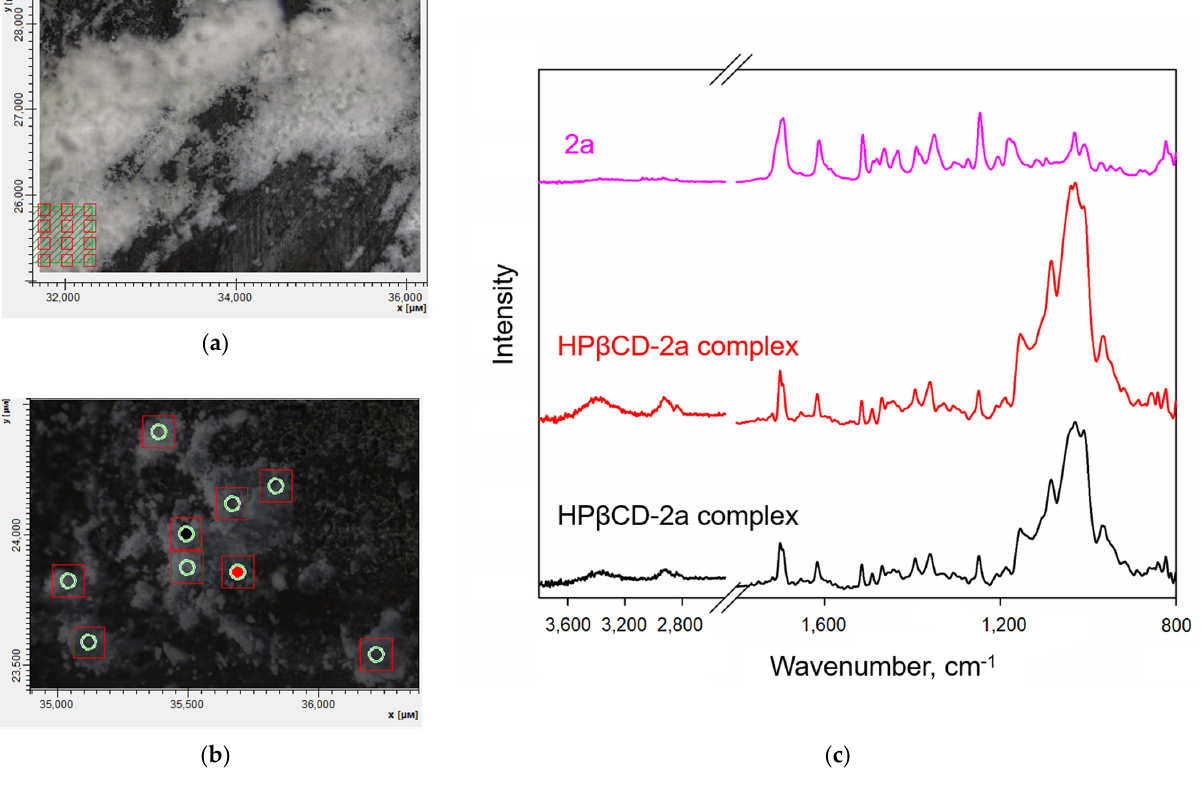
Figure 9. Microscopy photo of ( a ) 2a and ( b ) HP β CD- 2a complex. ( c ) FTIR spectra of 2a (pink curve) and HP β CD- 2a [red and black curves correspond to red and black areas circled in light-green in the photo (b)]. Table 2. Peaks in FTIR spectra of 2a and HP β CD- 2a , cm − 1 .